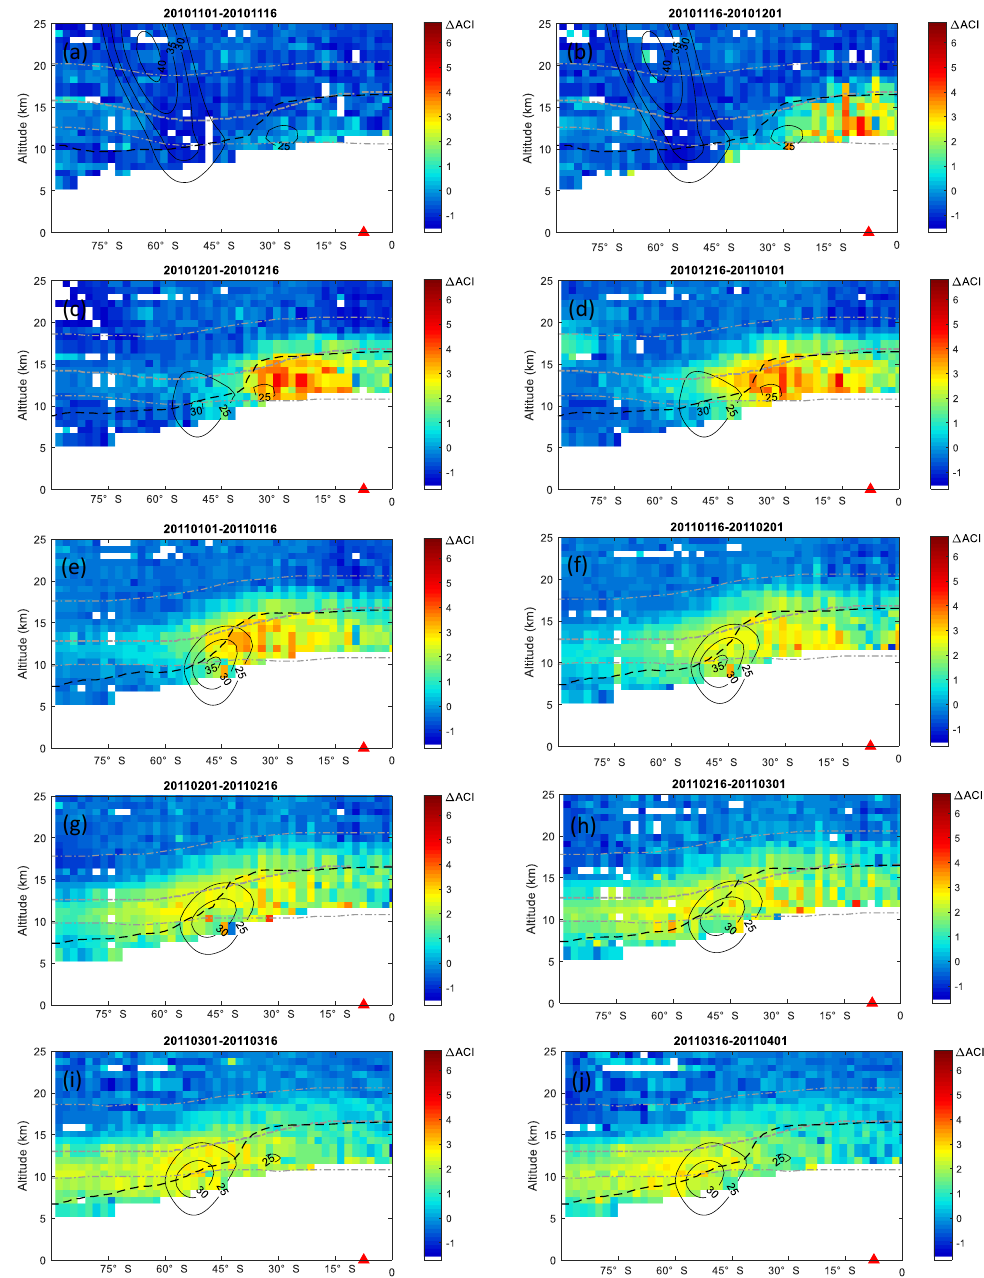
Figure 6. The change of MIPAS ACI values ( (cid:49) ACI) after the eruption of Merapi in 2010, overlaid with monthly mean zonal winds (black contours), the thermal tropopause (black dashed line), the 380K potential temperature isoline (thick gray dashed line) and 350 and 480K potential temperature isolines (thin gray dashed lines). (cid:49) ACI values are derived by subtracting the biweekly median ACI between November 2010 and March 2011 from the biweekly median ACI of the reference period between November 2007 and March 2008. Positive values indicate an increase of the aerosol load and negative values indicate a decrease of the aerosol load. Please see the text for details. Results are binned every 2 ◦ in latitude and 1km in altitude. The red triangle denotes the latitude of Mount Merapi. Please see title of each panel for the time period